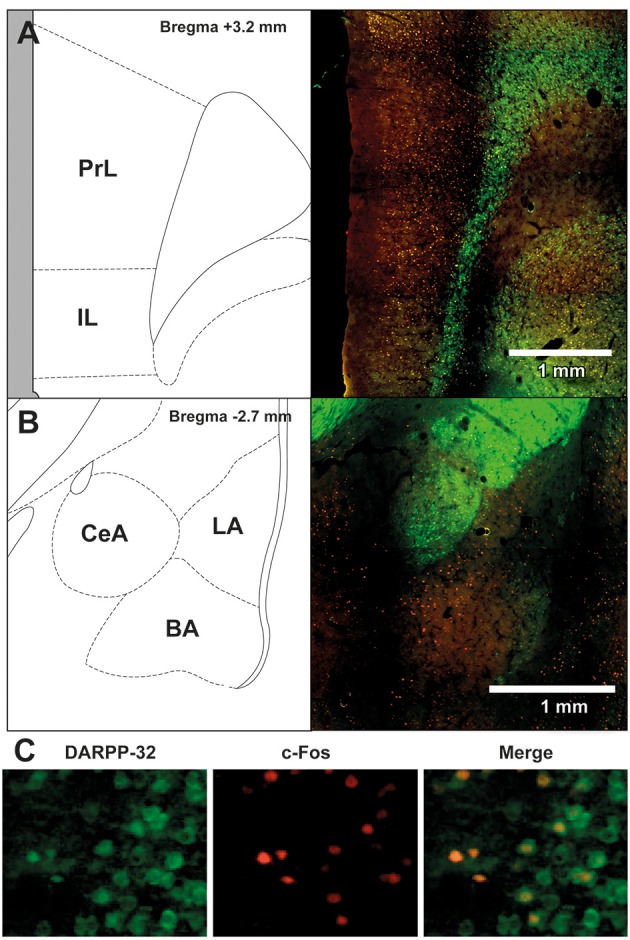
Representative images of the immunohistochemical staining for DARPP-32 positive (green) and c-Fos positive cells (red) in (A) medial prefrontal cortex (mPFC), including the prelimbic (PrL) and infralimbic (IL) regions, and (B) amygdala, including the central amygdala (CeA), basal amygdala (BA) and lateral amygdala (LA) subregions. The left panels show the anatomical schemactic taken from the rat atlas (Paxinos and Watson, 1998) that was used to define boundaries of individual subregions within the mPFC and amygdala. (C) Representative image taken from a rat in the extinction—aripiprazole group, of DARPP-32 positive cells (left panel, green), c-Fos positive cells (middle panel, red) and merge (right panel) showing cells that are co-labeled with c-Fos and DARPP-32.